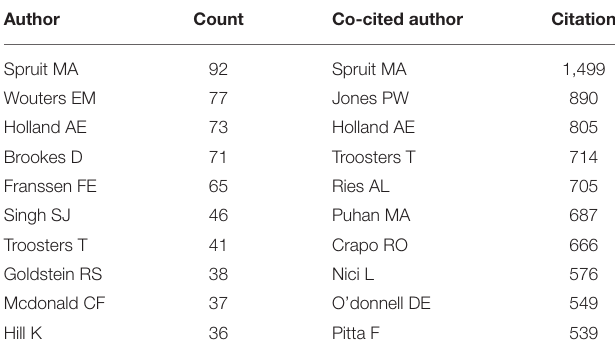
TABLE 1 | Top 10 authors and co-cited